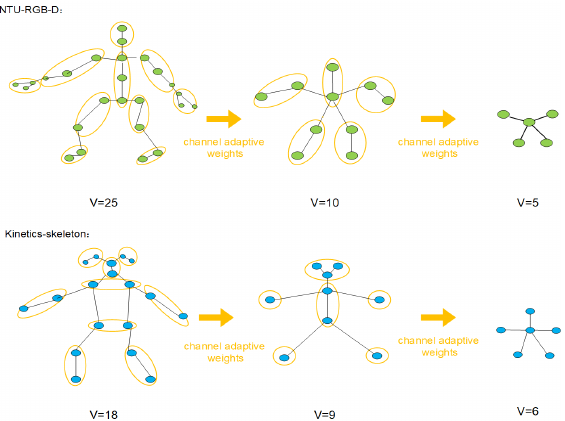
Figure 2. Illustration of the channel adaptive merging operation for the human skeleton graph of NTU-RGB+D and kinetic-skeleton. Vertices in one yellow circle are merged into one vertex in a weight-sum manner. Every channel has its weights to merge the